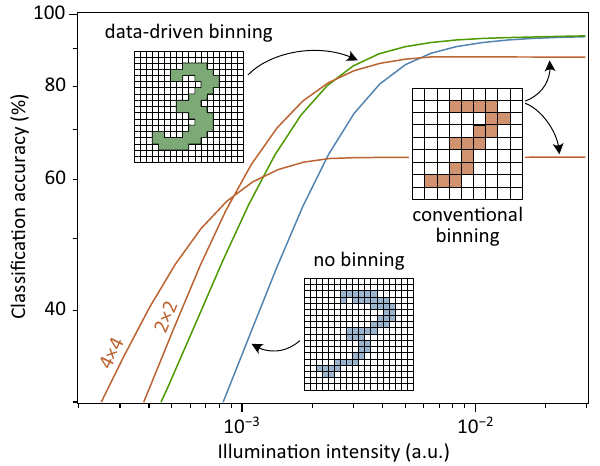
Figure 1. ANN classification accuracy for different types of binning. Simulated light intensity-dependent classification accuracy (MNIST, digits ‘0’…’9’, additive Gaussian noise) of the ANN in Fig. 4a. Blue line: without binning (28 × 28 pixels). Orange lines: with binning (14 × 14 pixels; K = 4 ) and (7 × 7 pixels; K = 16 ). Green line: data-driven binning. The network has been retrained in each case. Conventional binning allows to extend the dynamic range towards lower light intensities, but comes at the expense of reduced accuracy at large illumination intensities. Data-driven binning does not suffer from this drawback.